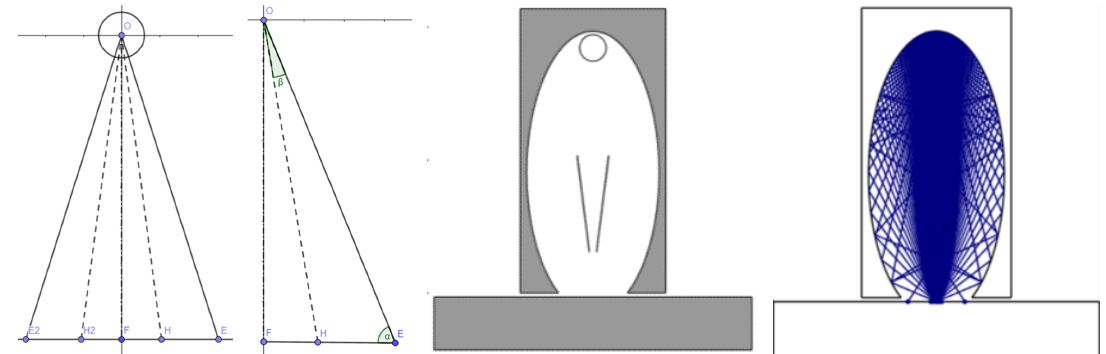
Figure 3. ( Left ) This figure shows a geometrical representation in order to calculate the amount of the radiation not being reflected by the elliptical reflector. The left image represents the complete set-up with the halogen tube lamp in point O and the focal point in point F. E 2 E represents the width of the illuminated region by direct rays leaving the tube lamp. The right image can be used to determine the angles needed to calculate the unwanted illuminated area. Representation of the optimised reflector shape and the related ray trajectories. ( Middle ) Optimised reflector shape established through ray-tracing simulations. The optimised heating source consists of an external reflector in the shape of an ellipse and additional straight reflectors in the middle. The halogen tube lamp is placed in the upper focal point of the ellipse. ( Right ) Ray trajectories according to ray-tracing simulation. The vast majority of the electromagnetic rays are focussed in the second focal point of the ellipse. The minority that intersects with the sample outside the focal point are reflected from the additional reflectors in the heat source. The heating power coming from these rays is